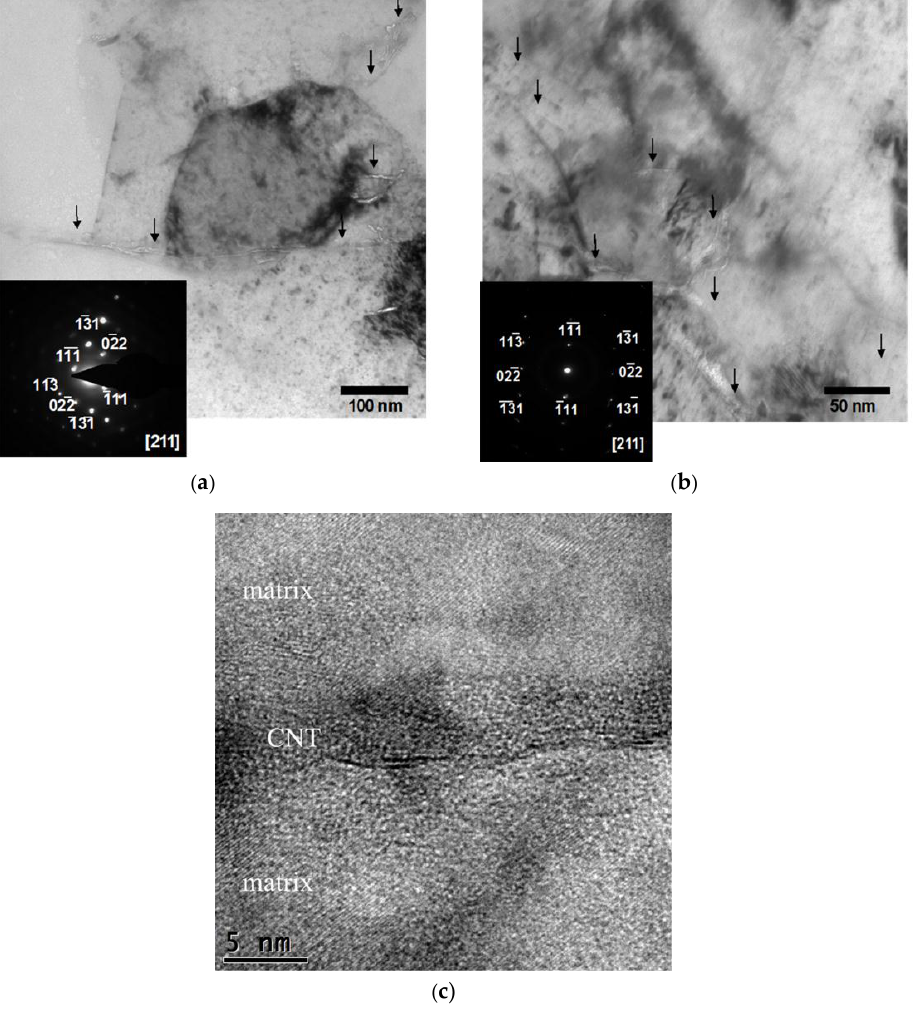
Figure 5. TEM images of the ( a ) Al/CNTs and ( b ) Ni/CNTs with the selected area electron diffraction (SAED) of the matrix and ( c ) HRTEM image showing a CNT.